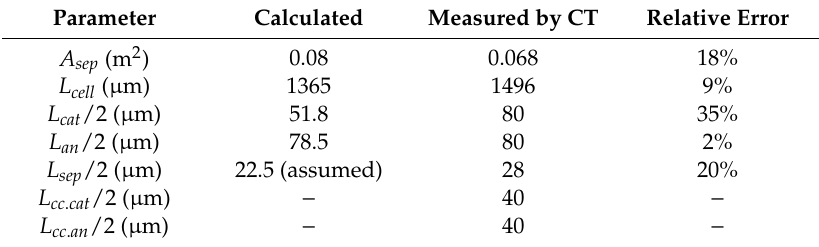
Table 4. Validation results based on CT and GITT. The parameter uncertainty of the thicknesses of the electrodes due to read error was on average 11%, while it was 25% for the thickness of the separator. Parameter Calculated Measured by CT Relative Error A sep (m 2